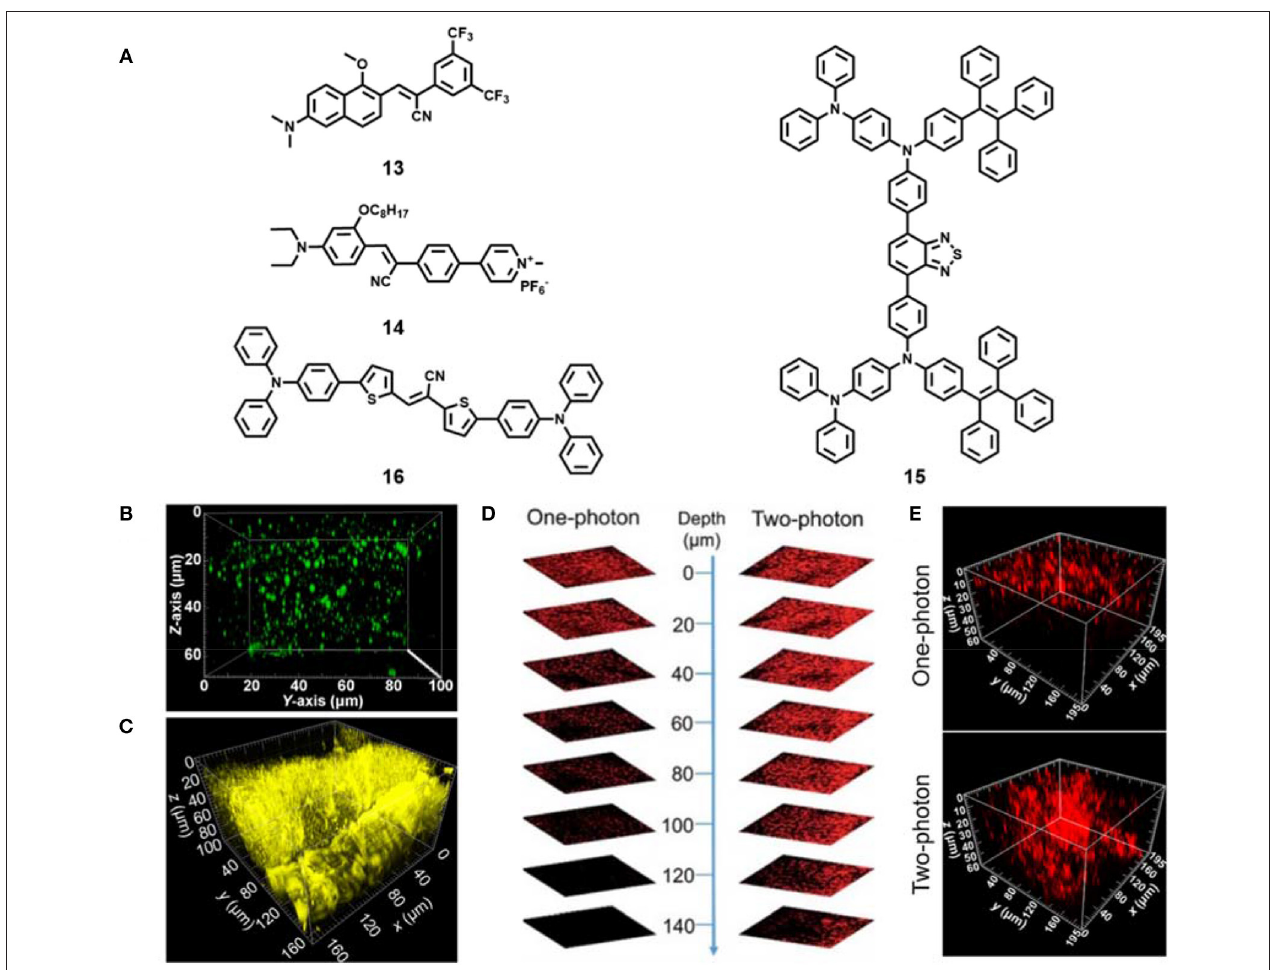
FIGURE 4 | (A) Chemical structures of AIE materials 13-16 for two-photon tissue imaging. (B) Reconstructed 3D two-photon fluorescence imaging of lipid droplets in live mouse liver tissues incubated with AIE material 13 (reproduced with permission from Niu et al., 2018; Copyright 2018 American Chemical Society). (C) Reconstructed 3D two-photon fluorescence imaging of live mice muscle tissues incubated with AIE material 14 (reproduced with permission from Niu et al., 2019a; Copyright 2019 Elsevier). (D) One-photon and two-photon fluorescent images of mouse liver by intravenous injection with compound 15 based AIE dots (reproduced with permission from Qin et al., 2018; This figure is extracted from an open access journal with thanks; Copyright 2018 The Royal Society of Chemistry). (E) Reconstructed 3D One-photon and two-photon fluorescent images of mouse tumor by intratumor injection with compound 16 based AIE NPs (reproduced with permission from Niu et al., 2019b; Copyright 2019 American Chemical